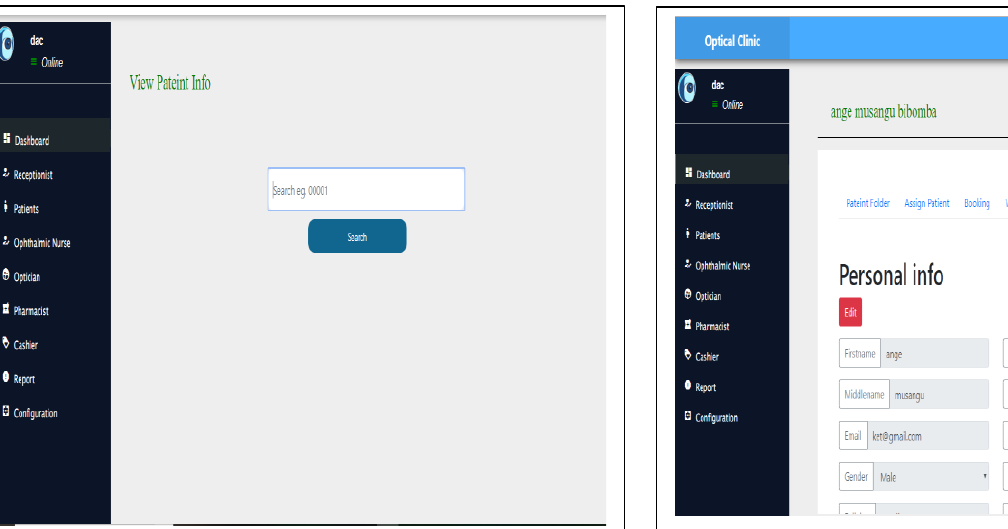
Figure 24. Amendment of Patient Information